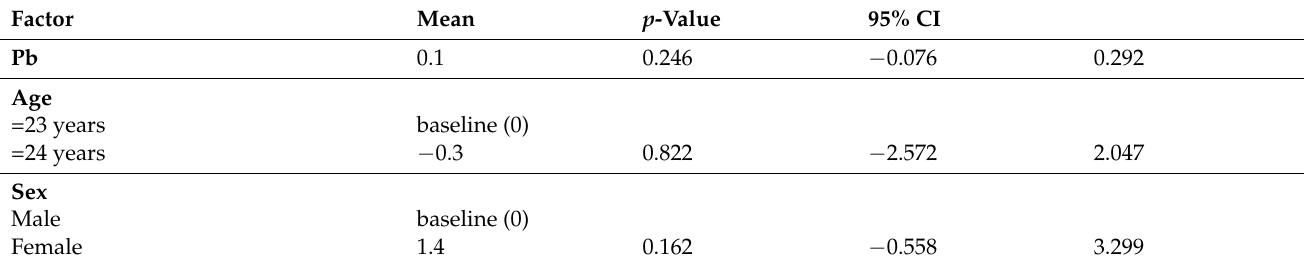
Table 4. Unadjusted univariate model showing the association between bone lead concentration and anger